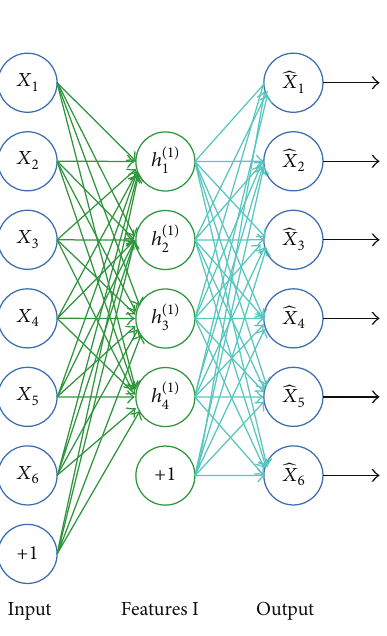
Figure 6: First-order representation.